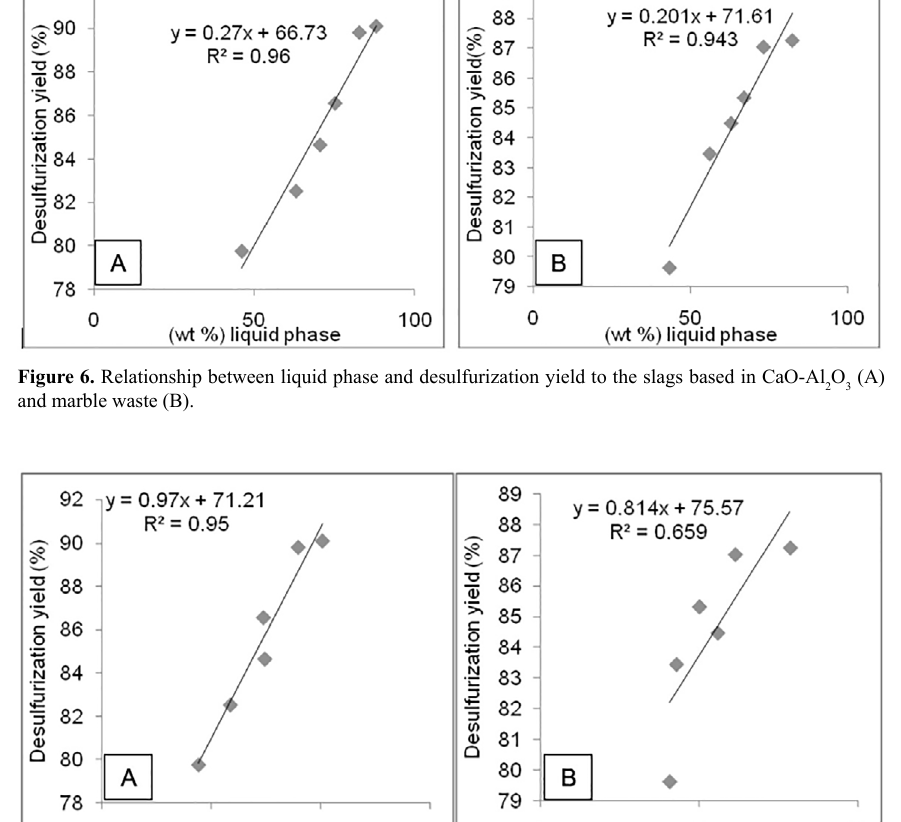
Figure 7. Relation between CaO content in the liquid phase and desulfurization yield of the slags based on conventional lime (A) and marble residue (B).